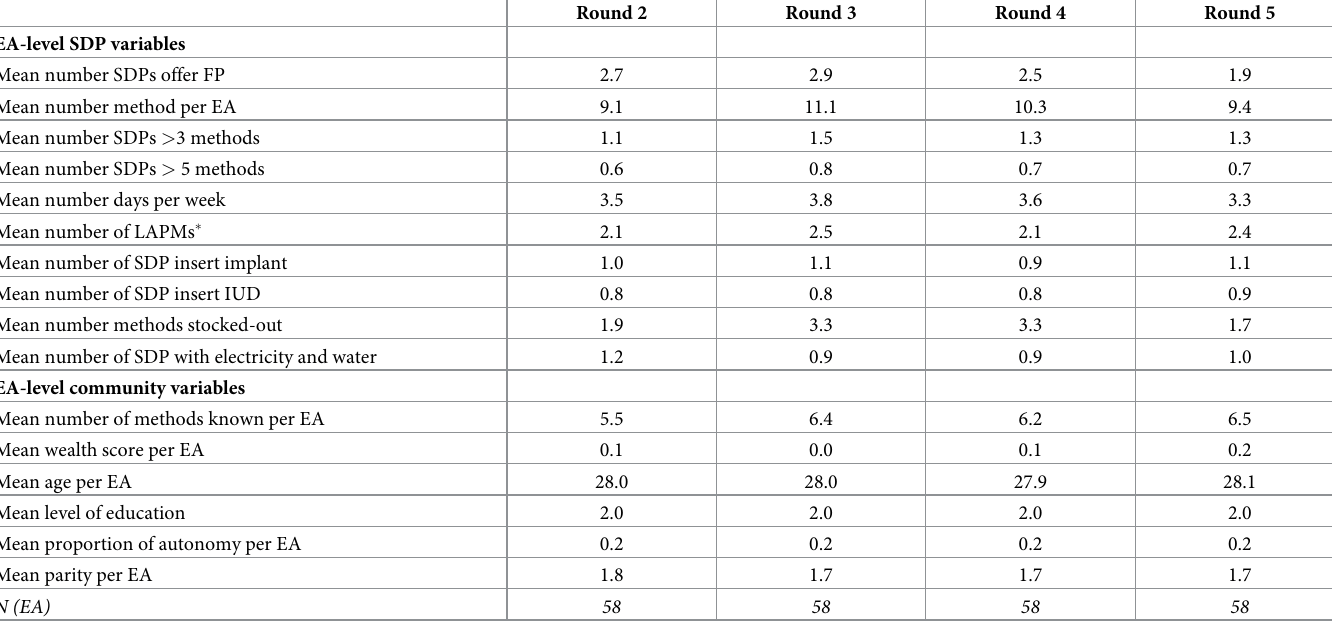
Table 3. Family planning service availability per EA, PMA 2020, 2014–2016, Kinshasa,